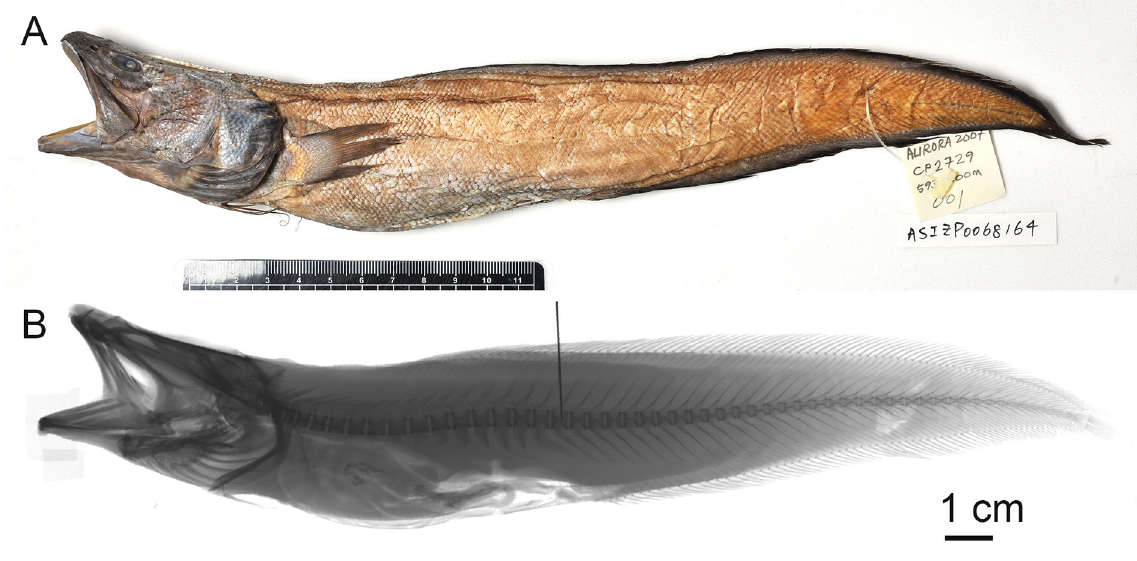
Fig. 6. Luciobrotula bartschi Smith & Radcliffe 1913. Voucher specimen, 301.7 mm SL (ASIZP 0068164). A . Preserved specimen. B . Radiograph. Needle points to the end of the